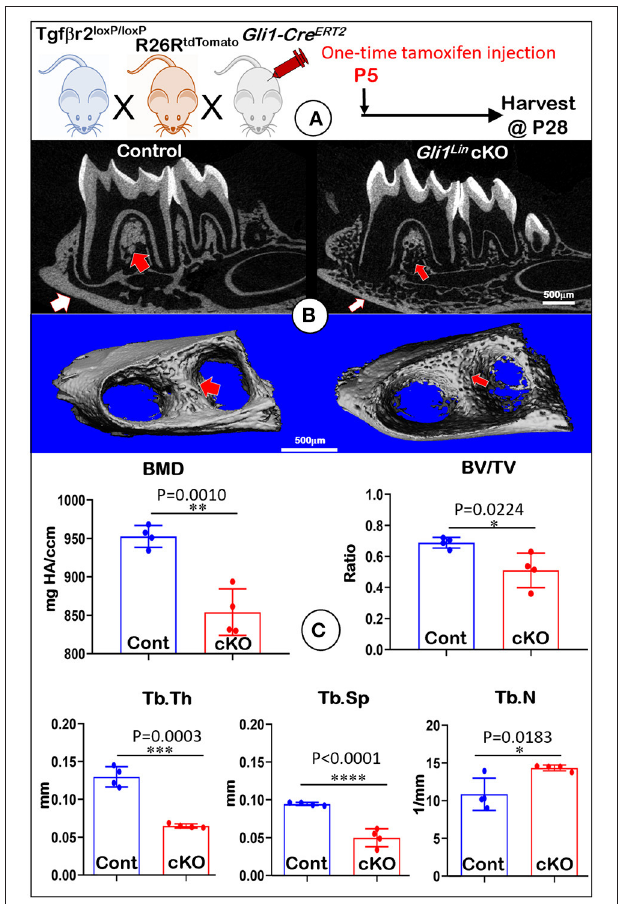
FIGURE 1 | Micro-computed tomography ( µ CT) analyses showed defective mandibles from Gli1 Lin Tgf β r2 conditional knockout (cKO) mice. (A) A schematic illustration of the generation of the Gli1-Cre ERT 2 induced Tgf β r2 cKO mice in the R26R tdTomato tracing background. A one-time tamoxifen injection was administered at P5, and harvested at P28. (B) The cKO mice showed remarkable decrease of bone mass at both trabecular (red arrows) and cortical (white arrows) regions. (C) Quantitative data based on the trabecular bone showed a significant reduction in bone mineral density (BMD) ( upper left ), the bone volume fraction (BV/TV) ( upper right ), and trabecular thickness (Tb.Th) ( lower left ), and trabecular separation (Tb.Sp) ( lower middle ). Of note, there was significant increase in trabecular number (Tb. N) ( lower right ). n = 4, * P < 0.05 ; ** P < 0.01 ; *** P < 0.001 ; **** P < 0.0001 .